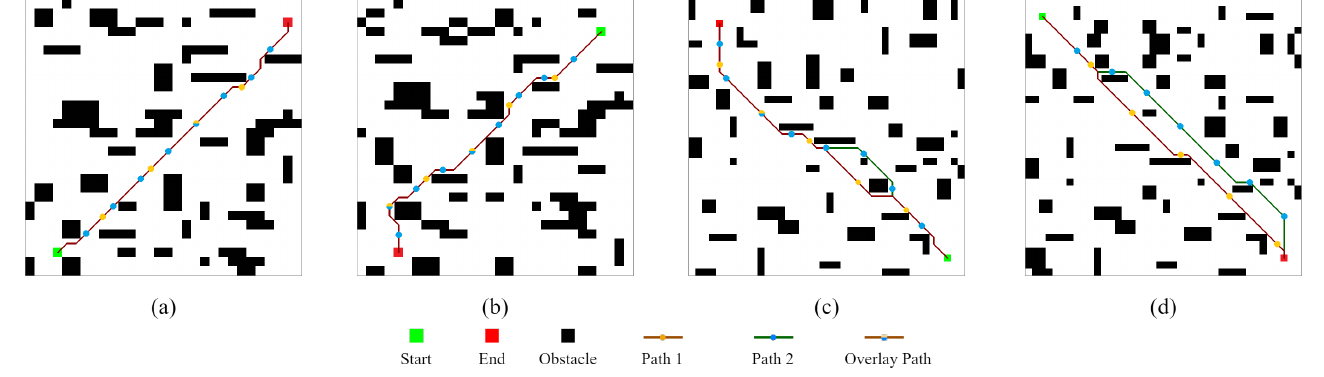
Figure 6. Obtained paths by the proposed CLSQL. ( a – d ) are the obtained path in Env1 to Env4.